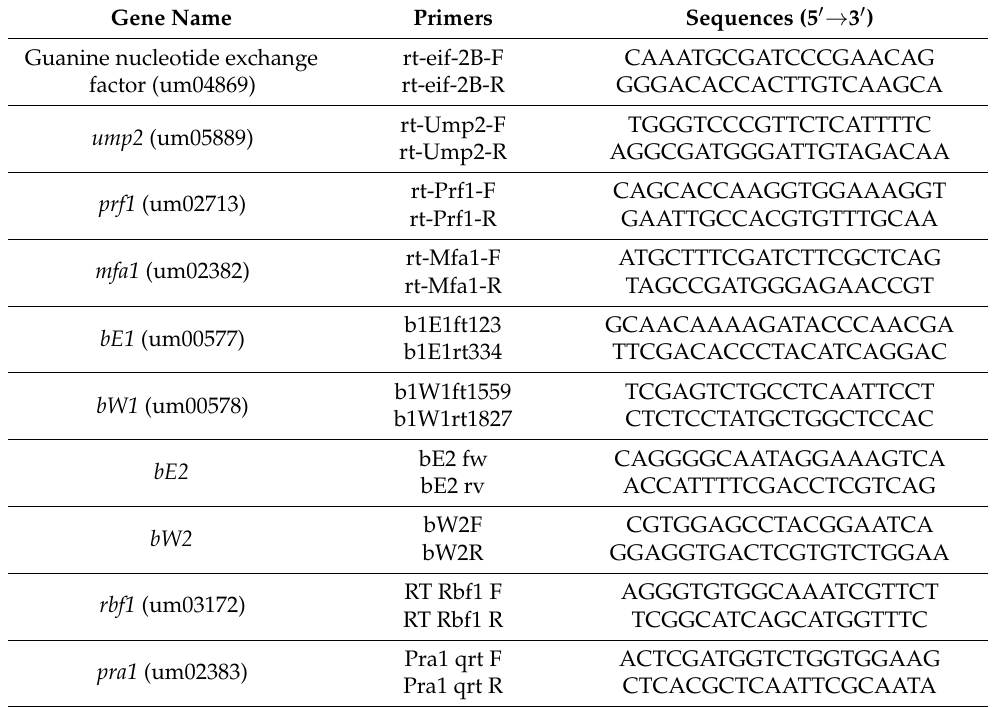
Table 2. qRT-PCR